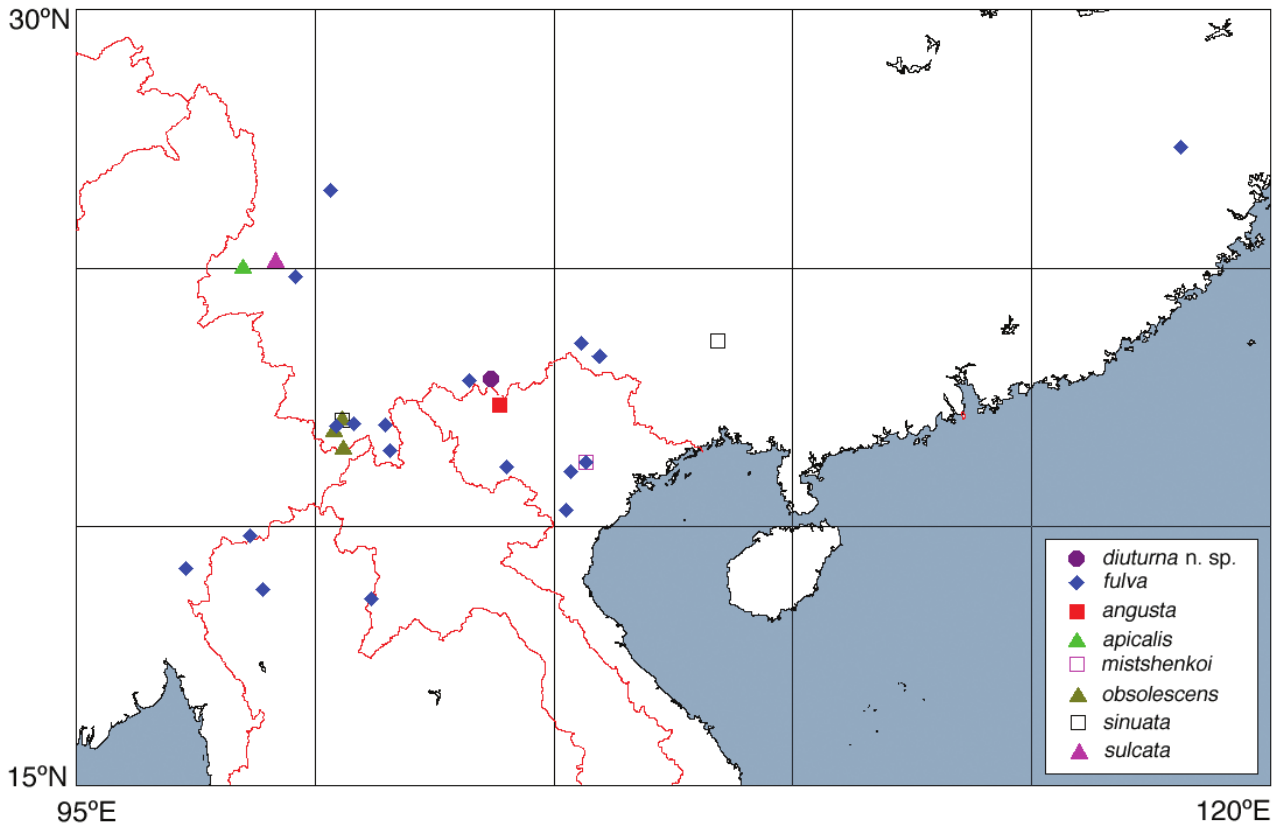
Figure 1. Distribution map of genus Ectadia (except E. pilosa , Kashmir; based on data of Brunner von Wattenwyl 1893, Liu et al. 2004, Gorochov 2009, Bey-Bienko 1962, Ingrisch 1998, Bai and Shi 2014).